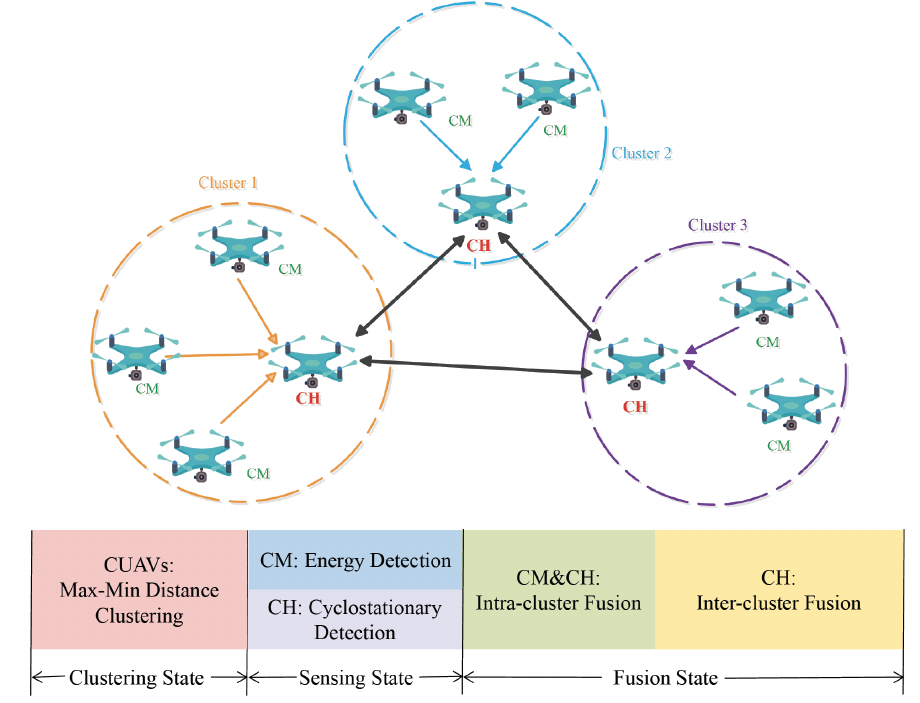
Figure 2. Heterogeneous Two-Stage-Fusion. Table 1.